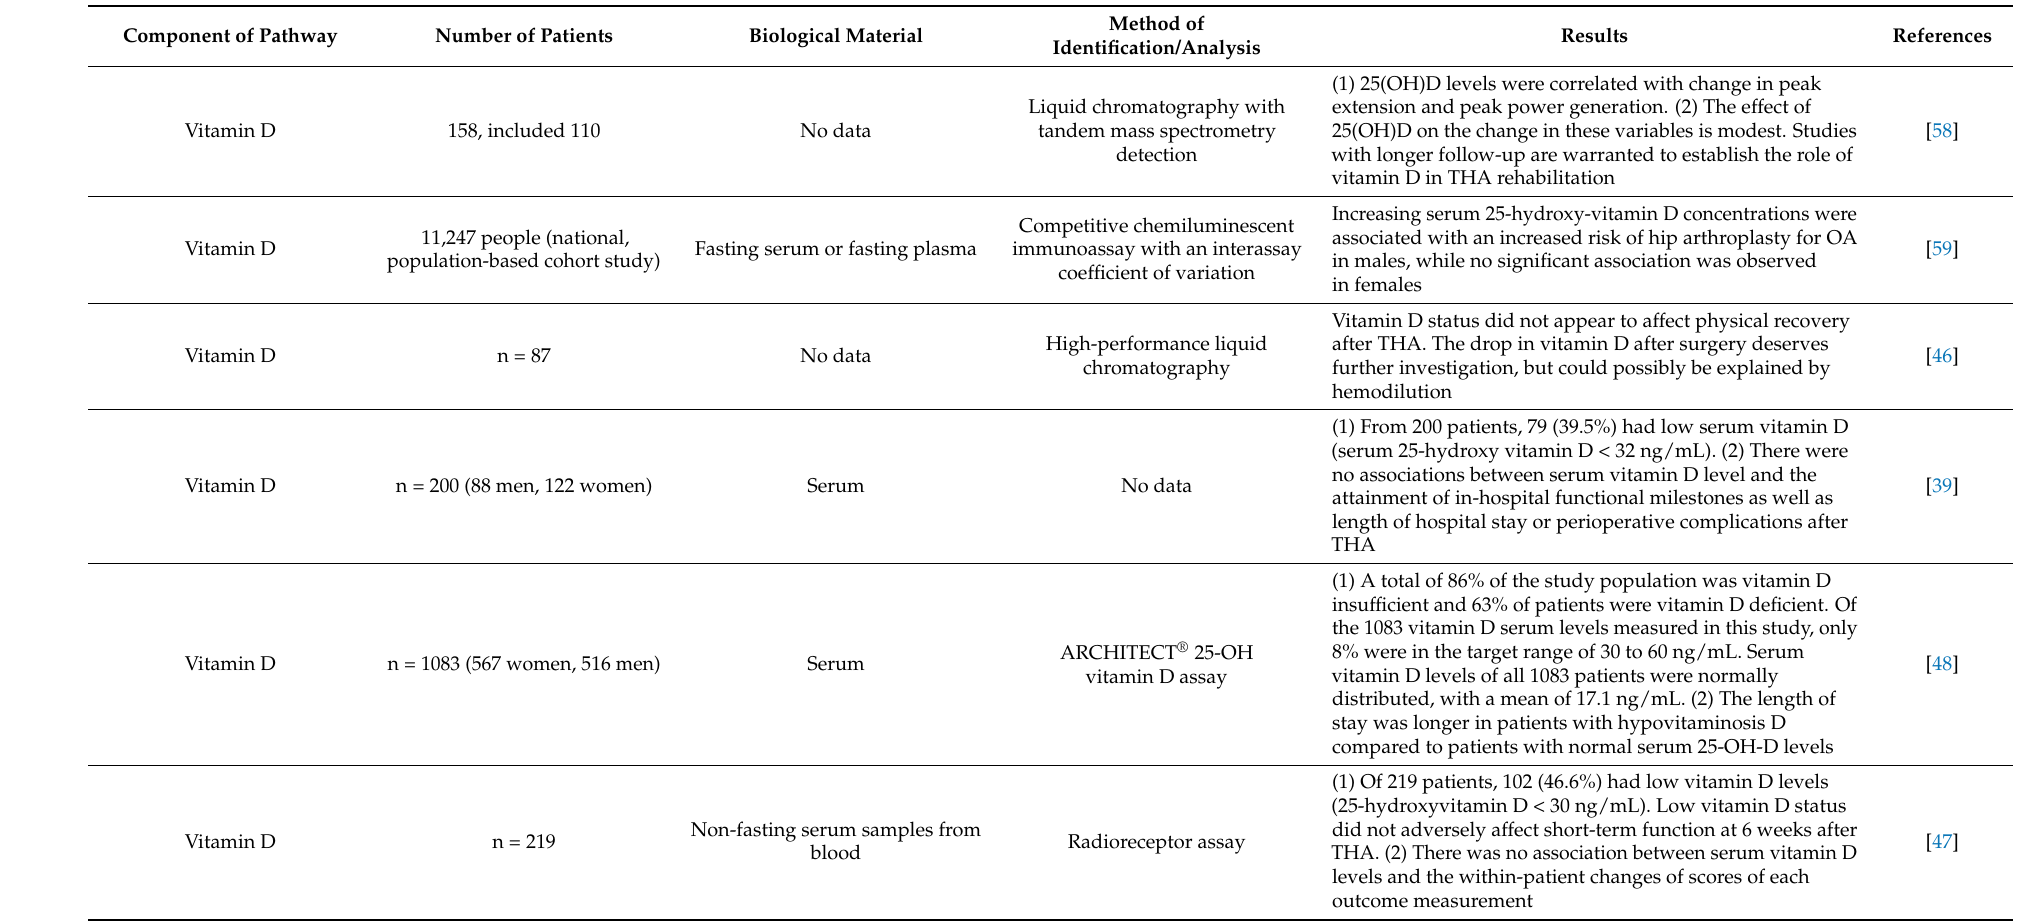
Table 2. Characteristics of the vitamin D metabolic pathway components in hip